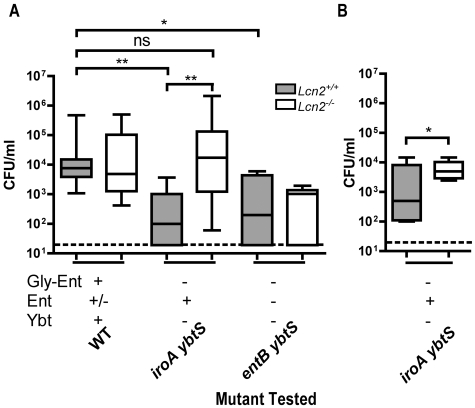
Mucosal lipocalin 2 is required to inhibit colonization by enterobactin-dependent K. pneumoniae.Colonization density of Lcn2+/+ (shaded symbols) and Lcn2−/− mice (open symbols) on day 3 after intranasal inoculation with 2×106 cfu of the K. pneumoniae mutants indicated (A). Box and whiskers graph shows the median and interquartile ranges for ≥10 mice per group; the dashed line is the lower limit of detection (20 cfu/ml). Siderophores encoded by each mutant are indicated by a plus (+). * p<0.05, ** p<0.01, ns p>0.05 as determined by Kruskall-Wallis Test with Dunn's post test. To remove the contribution of neutrophil-produced Lcn2, colonization density on day 1 was determined in Lcn2+/+ (n = 6) and Lcn2−/− mice (n = 8) treated with RB6-8C5 rat mAb to murine Ly6G one day prior to inoculation with 2×106 cfu of iroA ybtS mutant K. pneumoniae (B). * p<0.05 as determined by Mann-Whitney Test.